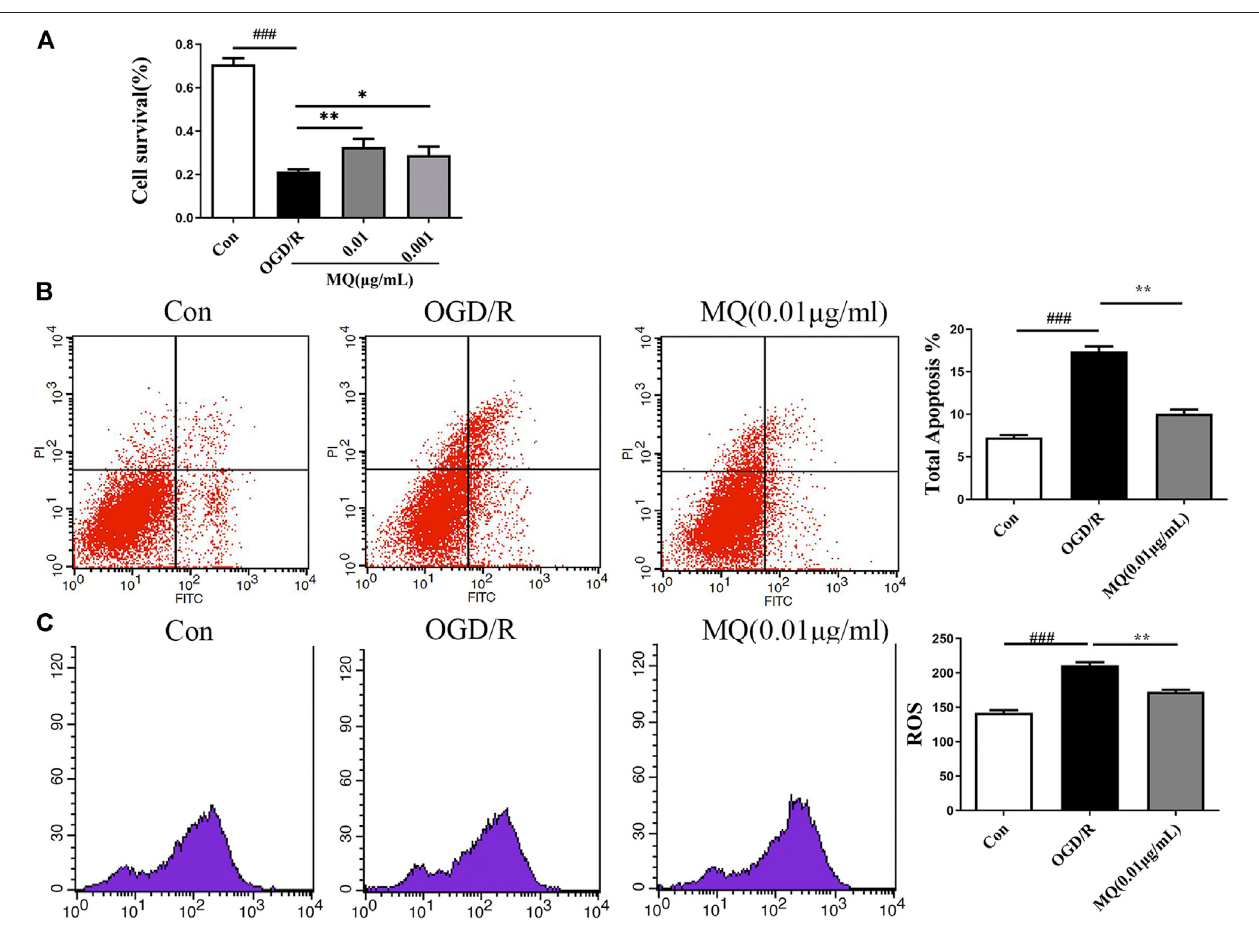
FIGURE 5 | MQ decreased cell apoptosis in OGD/R-induced PC12 cells. (A) MTT was used to test PC12 cell viability, (B) fl ow cytometry data showed the percentageoftotalapoptotic cellscompared totheOGDgroups, (C) fl owcytometrydatashowedthelevelofROSinPC12cells.MQ:0.01 μ g/mL; ### p < 0.001,control group vs. OGD group, * p < 0.05, ** p < 0.01, MQ group vs. OGD group, n ≥